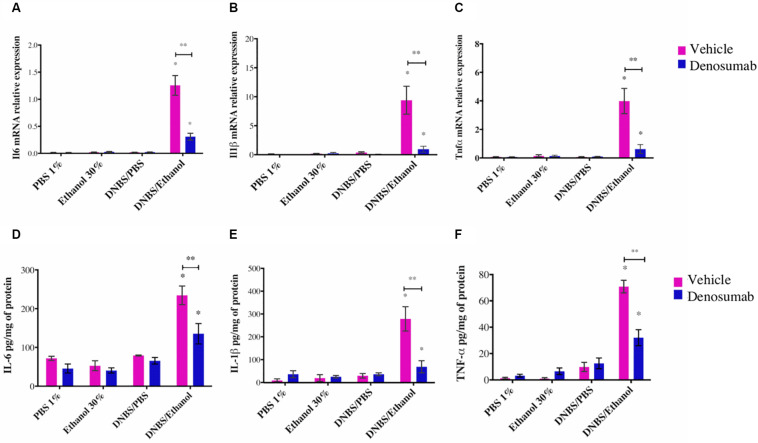
The effects of DNBS/Ethanol-induced colitis and denosumab treatment on the colonic IL1β, IL-6, and TNF-α pro-inflammatory cytokines. DNBS/Ethanol increased (p < 0.05) colonic pro-inflammatory cytokines (A–C). The cytokine expression levels were confirmed using qRT-PCR analysis (D–F). TATA Box Binding Protein (TBP) is used as housekeeping genes for qRT-PCR. Error bars are shown as SEM. ∗p < 0.001 when compared with other induction models within the denosumab or vehicle group, and ∗∗p < 0.001 when compared one induction model within the denosumab and vehicle group. calculated using SAS MIXED procedure and illustrated by Prism using two-way ANOVA. n = 6 mice per group.